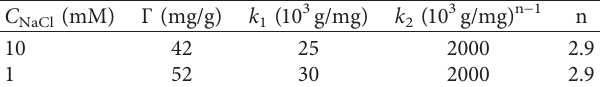
Table 1: The fit parameters for adsorption RhB onto SDS-modified α -Al 2 O 3 ( M 1).